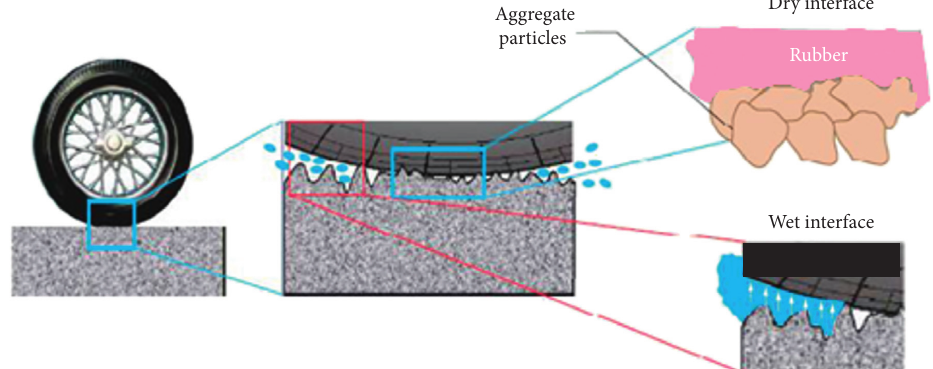
Figure 1: Skid resistance and hydrodynamic stresses at tire-pavement interface [15].